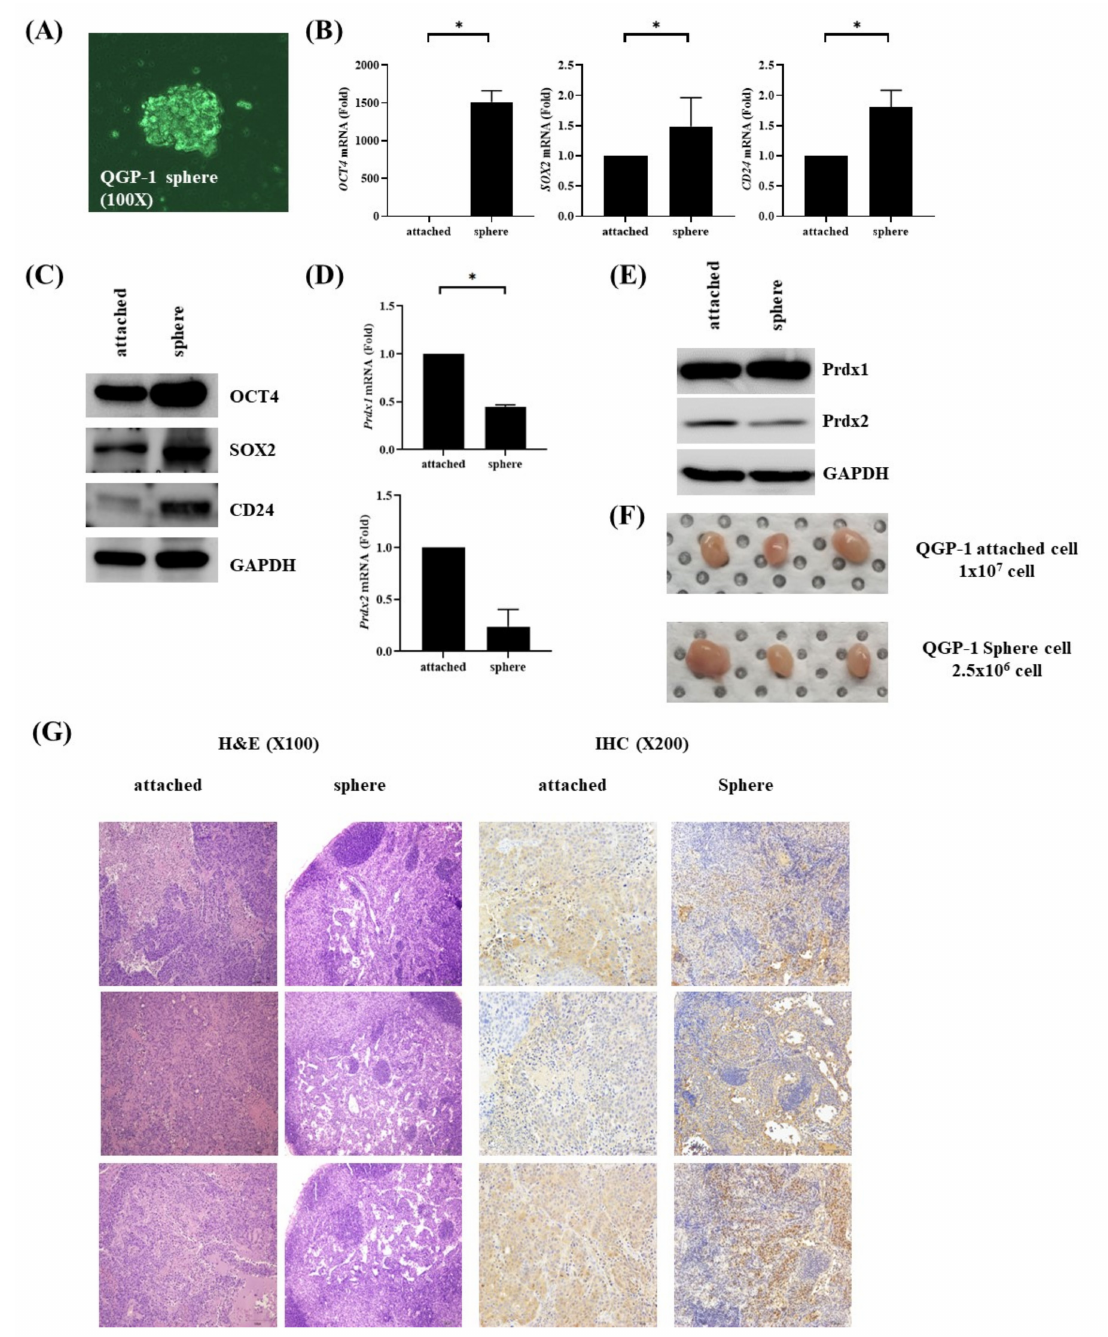
Figure 4. Prdx2 downregulation in pancreatic neuroendocrine tumor QGP-1 spheres. ( A ) QGP-1 spheres cultured via sphere formation assays; ( B ) The mRNA levels of Oct4, SOX2, and CD24 were upregulated in QGP-1 spheres as compared with the controls; ( C ) Western blotting revealed that OCT4, SOX2, and CD24 levels were higher in QGP-1 spheres than in the controls; ( D , E ) Prdx2 was downregulated in QGP-1 spheres as compared with the controls at the mRNA and protein levels; ( F ) In vivo tumor cell xenograft assay showed that injection of QGP-1 spheres (2.5 × 10 6 cells) resulted in the formation of a tumor comparable to that generated by QGP-1 cells (1 × 10 7 ); ( G ) Immunohistochemical staining of Prdx2 in xenografted tumor showing weak staining for Prdx2 in QGP-1 sphere cells with small to medium sized nests. Magnification H&E × 100, IHC × 200. * p <